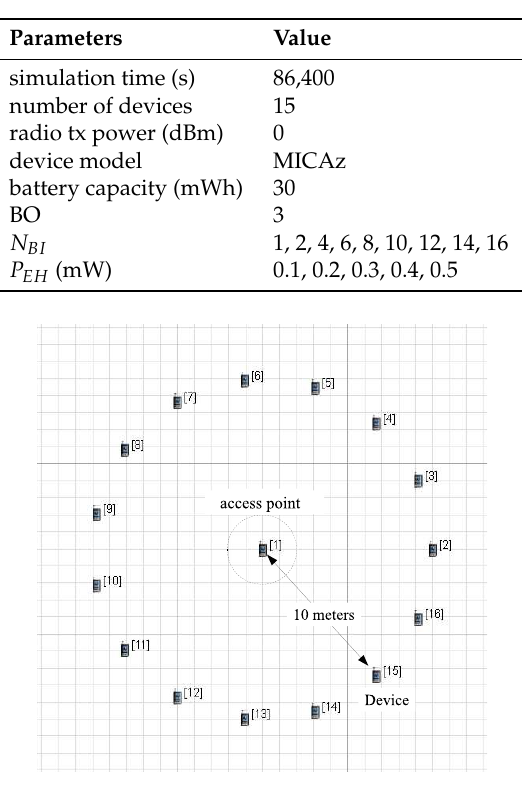
Figure 6. Deployment of an access point and devices in scenario